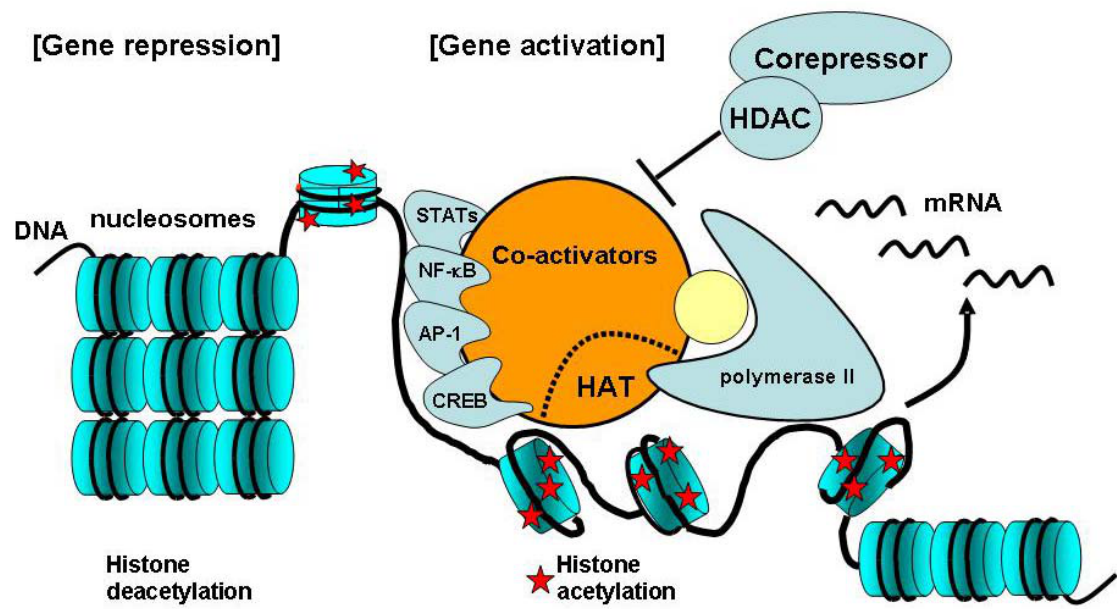
FIGURE 1 . Molecular mechanism of gene activation and repression. Gene activation and repression are regulated by acetylation of core histones. Histone acetylation is mediated by coactivators that have intrinsic HAT activity, opening up the chromatin structure to allow binding of RNA polymerase II and transcription factors that were unable to bind DNA in the closed chromatin configuration. This is reversed by corepressors, which include histone deacetylases (HDACs) and other associated proteins that reverse this acetylation, thereby causing gene silencing. STATs, signal transduction activated transcription